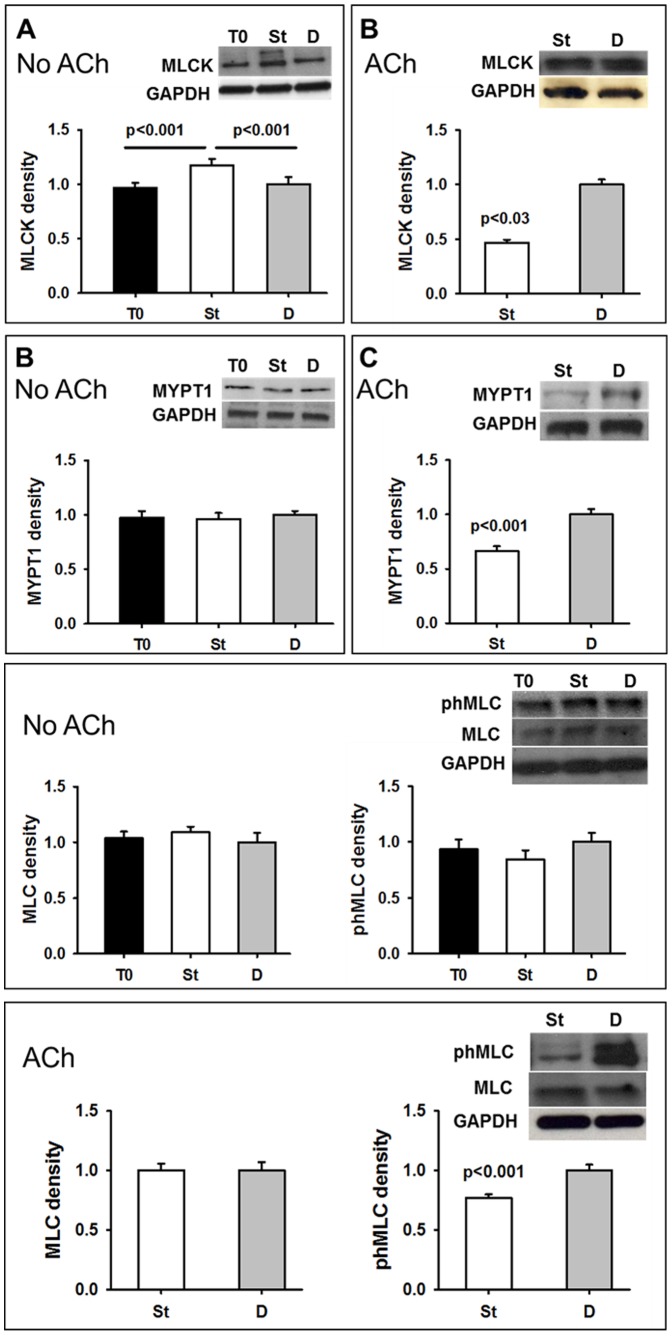
MLC activated only during dynamic loading with Ach challenge.Effects of Ptm on the cross-bridge activating contractile proteins MLCK (∼210 KDa) (A and B), MYPT1 (∼140 KDa) (C and D) MLC (∼20 KDa), and its activated form phMLC (∼20 KDa) (E and F) of intact bovine airway after 90 min of mechanical loading with (B, D and F) or without (A, C and E) constriction assessed by Western blot. Notice that the same membrane was used in B as in figure 3D. T0: time 0 before stretch, St: static Ptm. D: dynamic Ptm oscillation. GAPDH (∼35 KDa) is loading control. Data are normalized such that the mean of the dynamic group is unity.